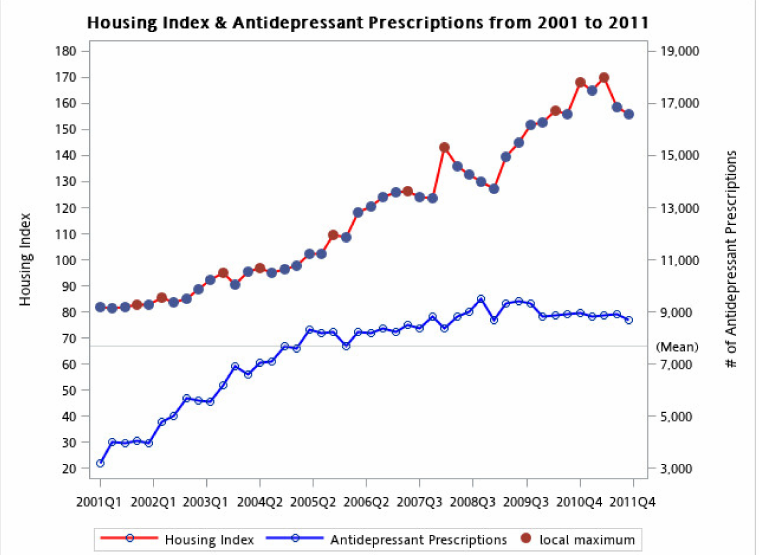
Figure 1. Growth trajectory of housing index and antidepressant prescriptions from 2001 to 2011. The figure shows the prevalence of antidepressant prescription along with the housing index, between the years 2001 and 2011. The housing indexes are presented with red dots while antidepressant prescriptions are marked in